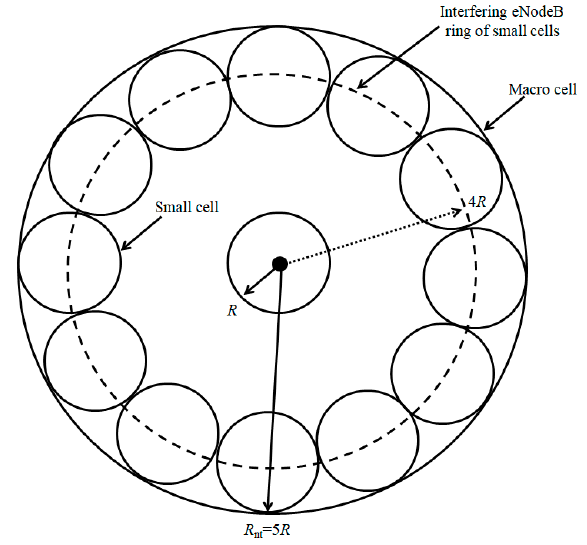
Figure 4. HetNet scenario for deployment of macro cells near the edge of the macro cell.